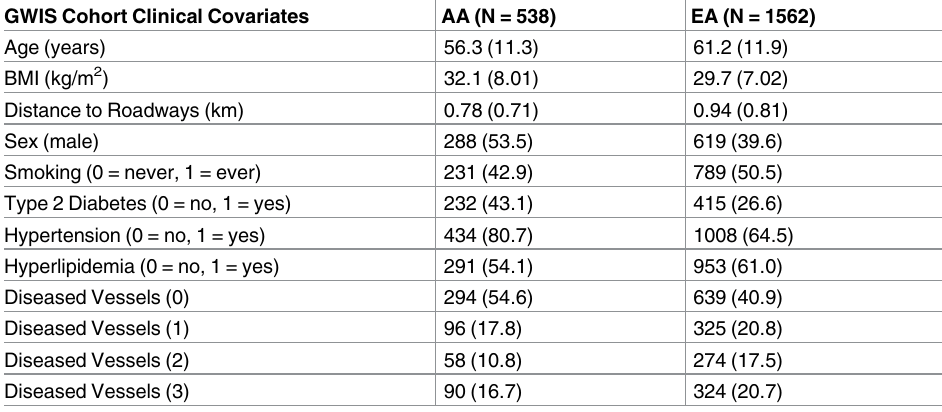
Table 1. GWIS cohort demographic and clinical covariates.